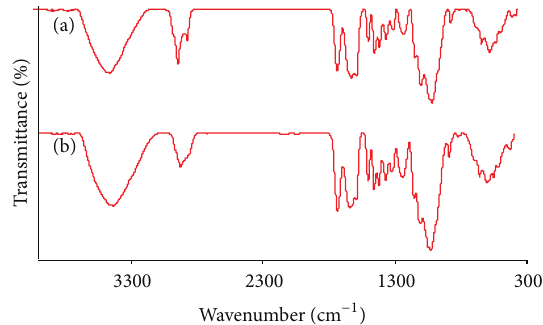
Figure 5: EDS of CaHBSD after copper adsorption.